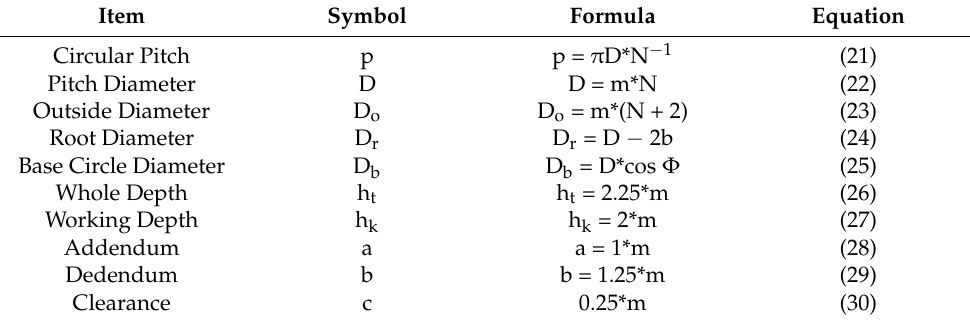
Table 5. Design calculation parameters